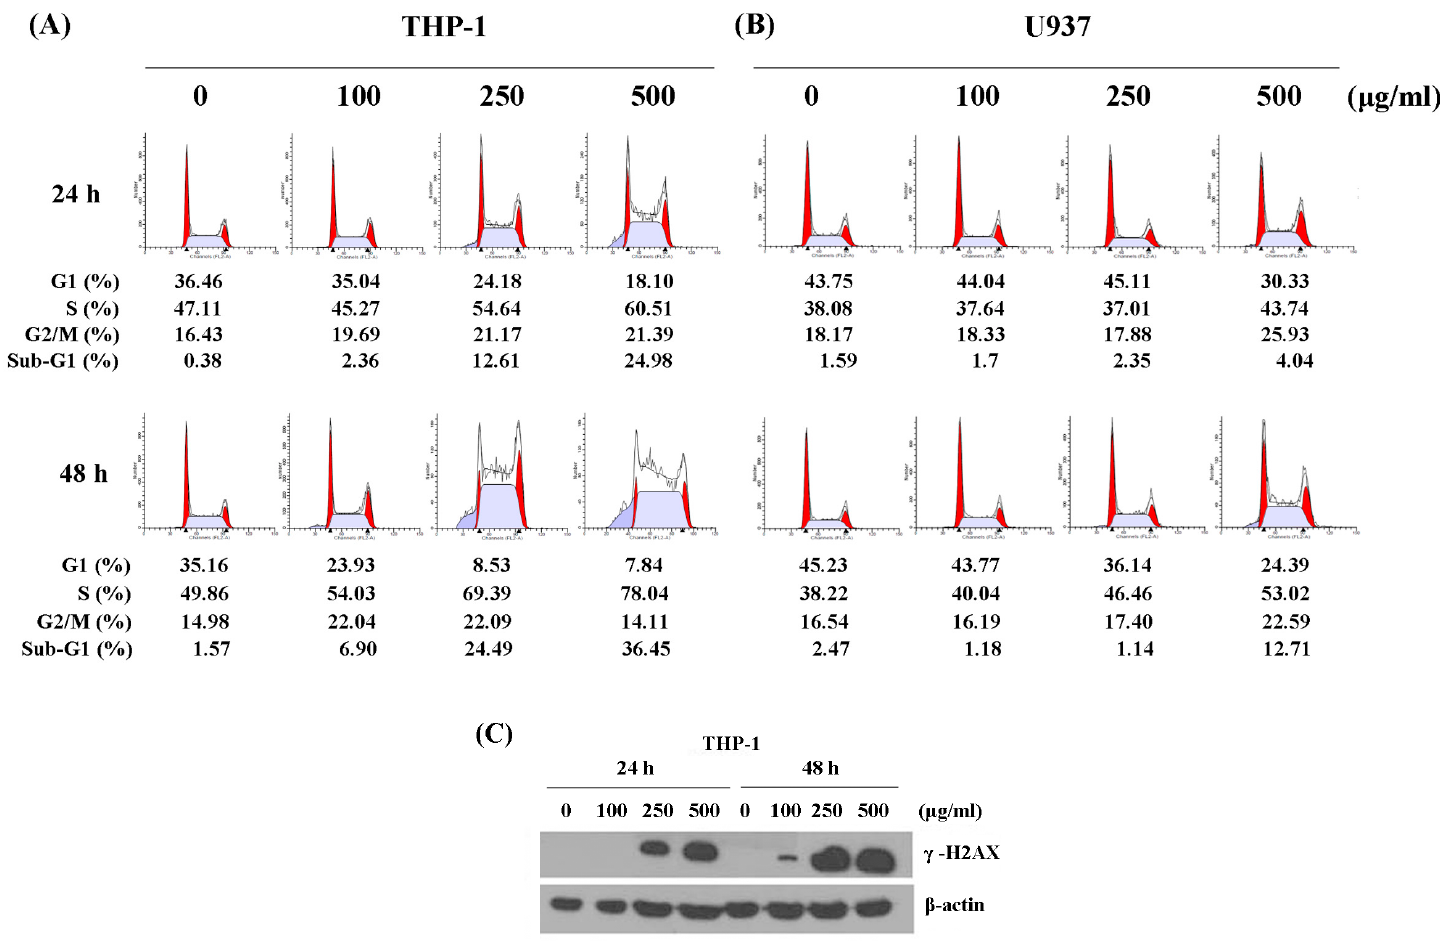
Figure 2. WSPIS disturbed cell cycle progression and caused DNA damage. ( A,B ) DNA content analysis. THP-1 and U937 cells were treated with various doses of WSPIS (100, 250 and 500 μ g/mL) for 24 and 48 h. DNA content was analyzed using flow cytometry after propidium iodide staining. ( C ) The protein level of γ -H2AX was determined by Western blotting in WSPIS-treated THP-1 cells. DNA content histograms and Western blotting data are representative of three independent experiments.